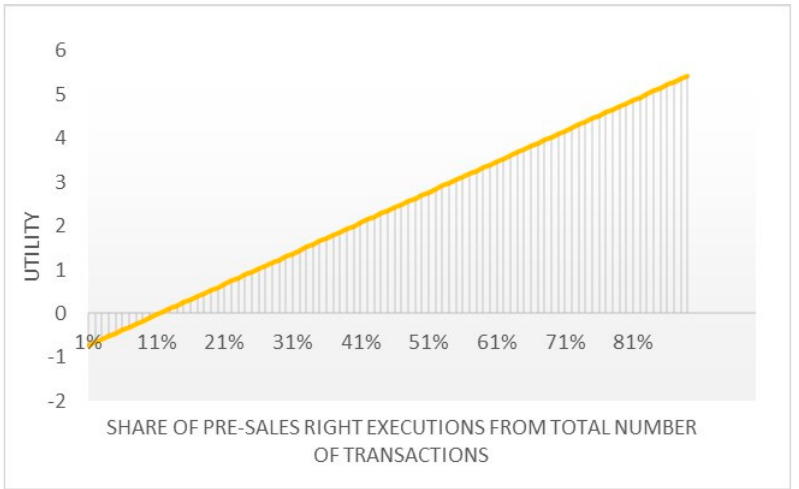
Figure 3. Example utility curve for the German land transaction law, based on Table 1 with 𝑝